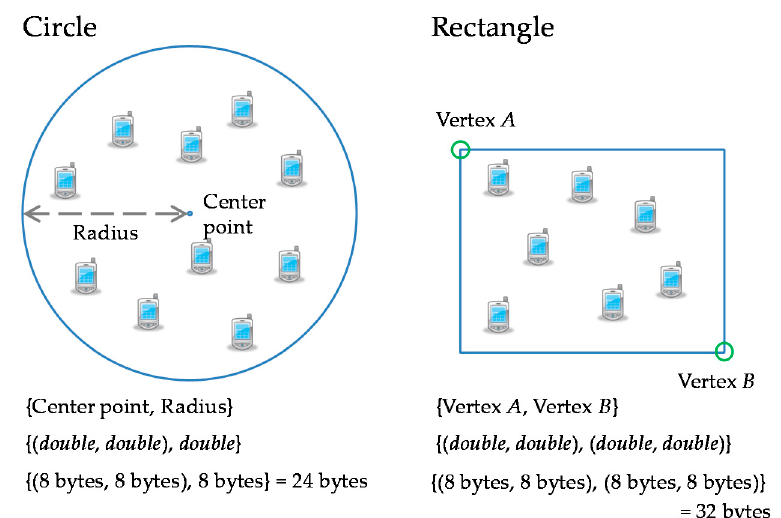
Figure 3. Two examples of destination area.